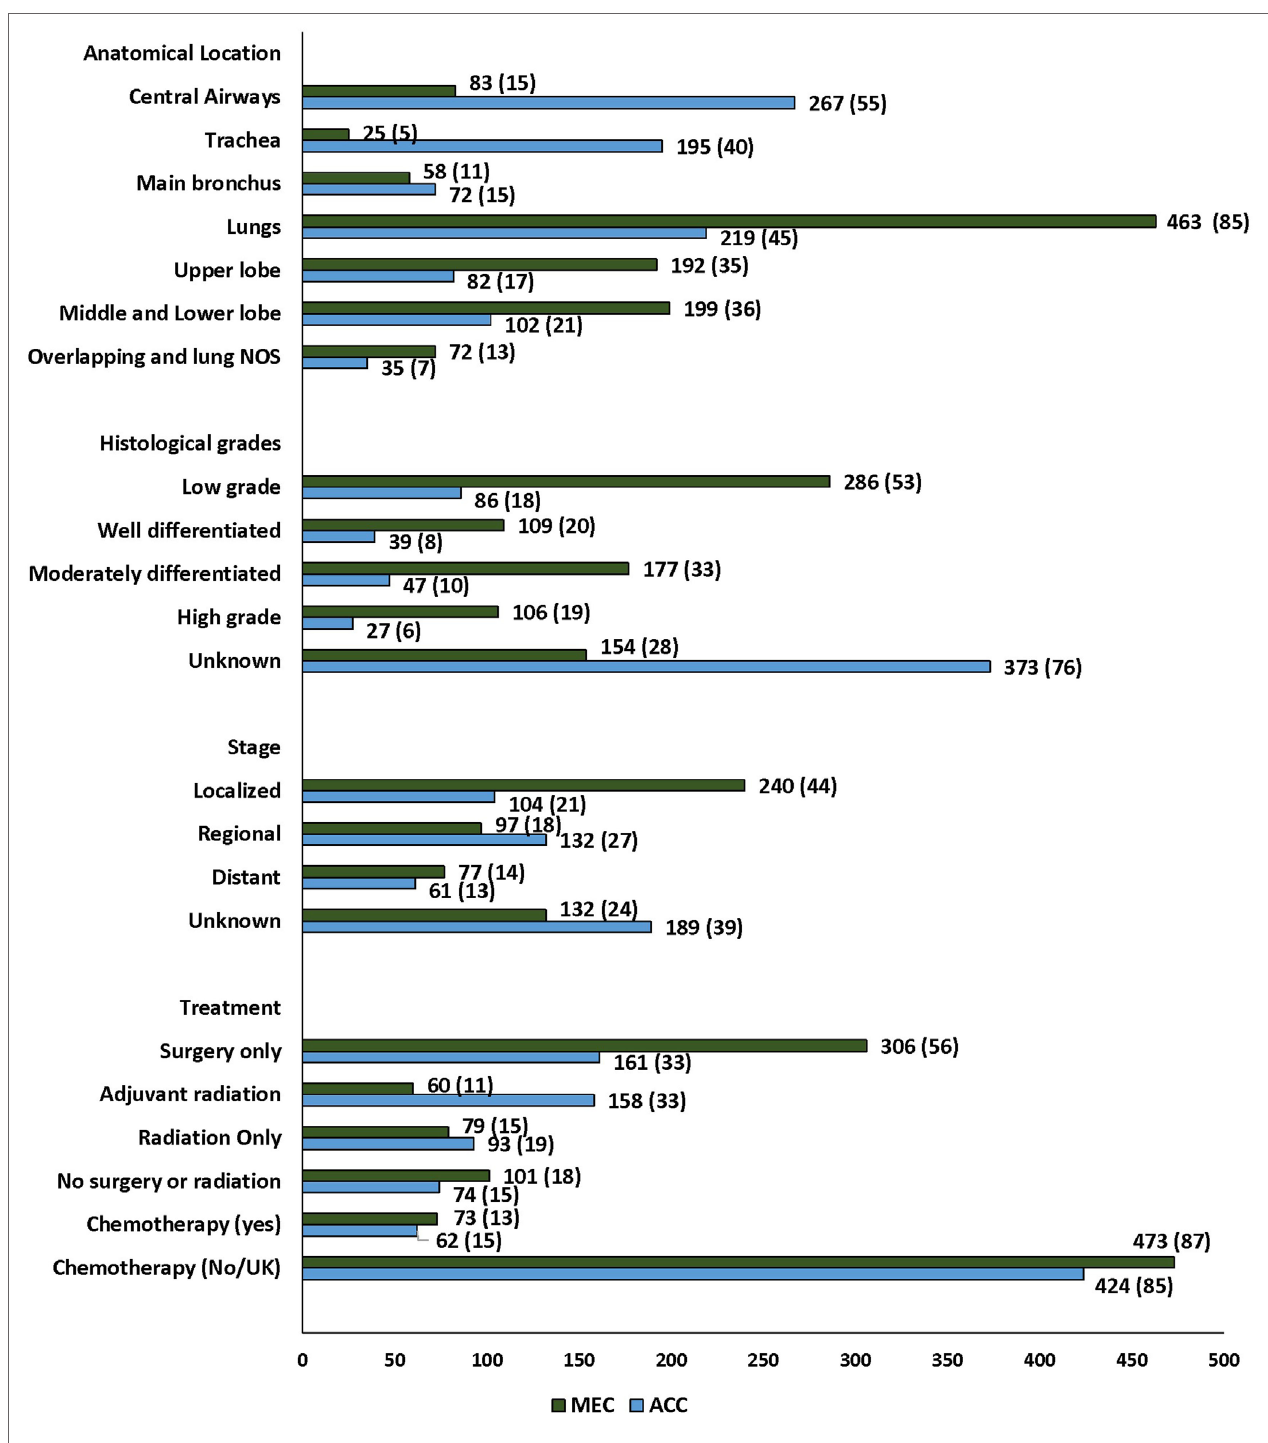
FigUre 1 | Characteristics and distribution of primary adenoid cystic carcinoma and mucoepidermoid carcinoma of lung in patients diagnosed in the Surveillance Epidemiology and End Results